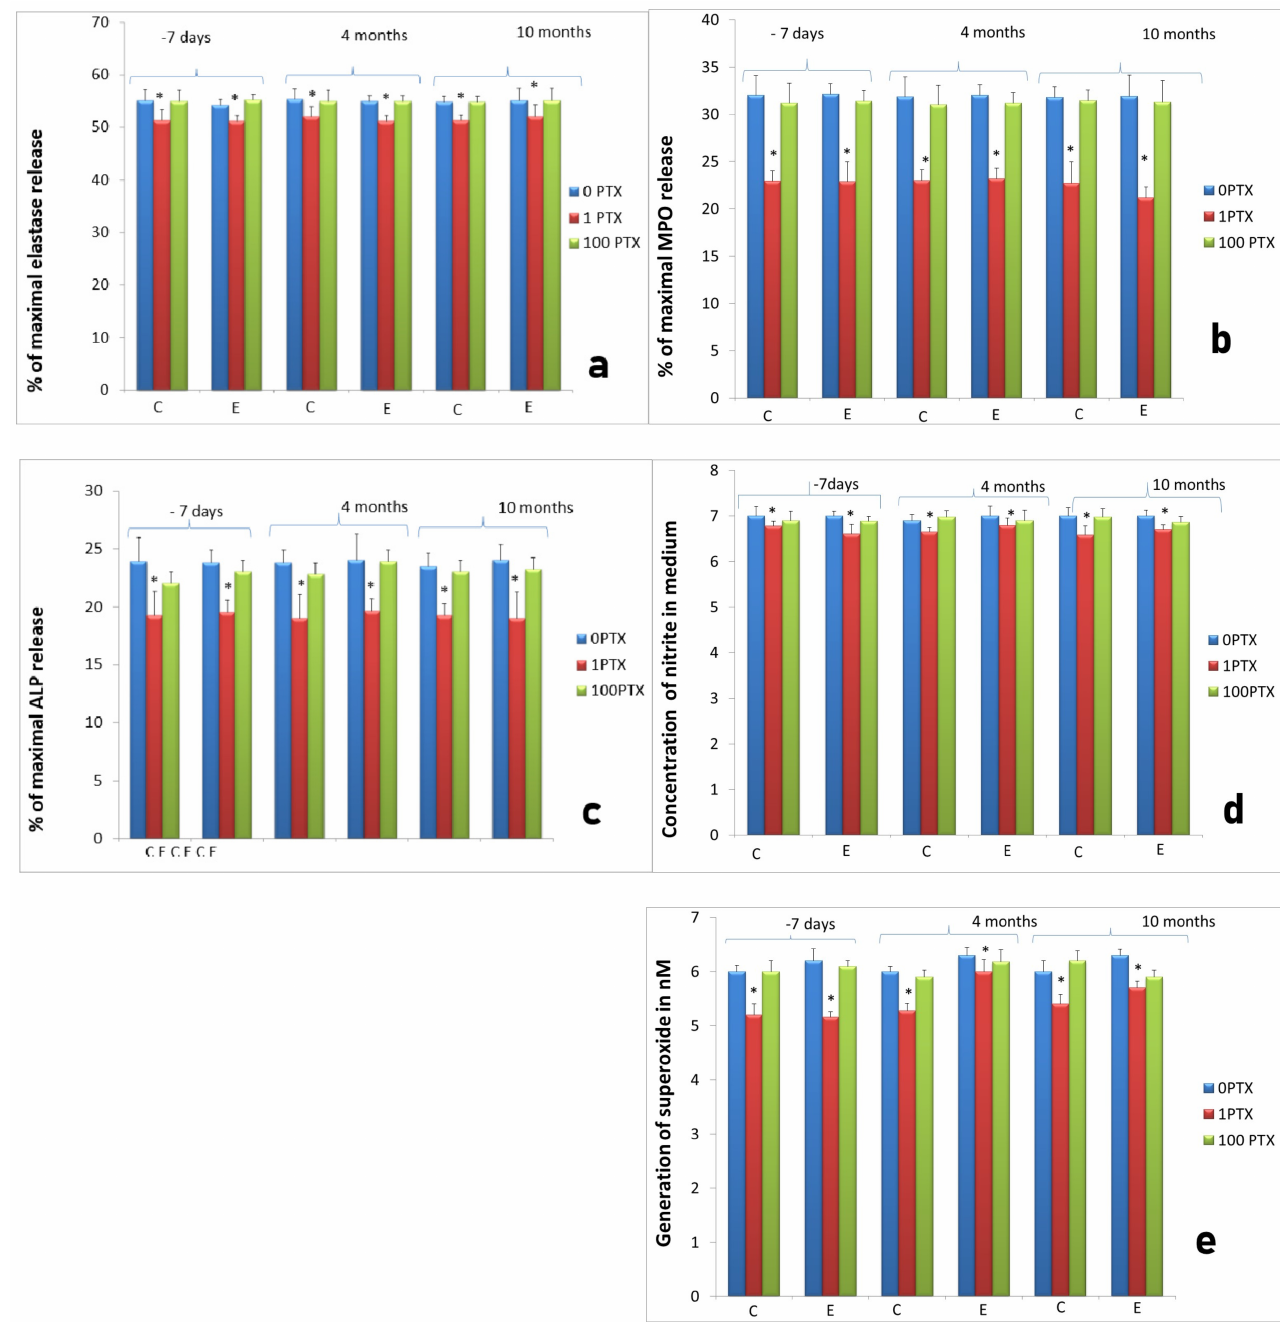
Figure 7. Activity of neutrophils isolated 4 and 10 months after implantation (experimental—8 sheep) compared to control groups of neutrophils isolated at the same time points from animals from control groups (control: 4 sheep). C—control group, E—experimental group. The response to implantation and treatment with two concentrations of PTX (1 and 100 µ g/mL); ( a ) elastase release from neutrophils, ( b ) MPO release, ( c ) ALP release, ( d ) NO generation, ( e ) superoxide generation assessed at two time points: 4 and 10 months after implantation. Data present mean values ± SE of at least three replicates for each bar. * p < 0.05 compared to cultures of neutrophils without stimulation (0 µ g/mL) at the same time